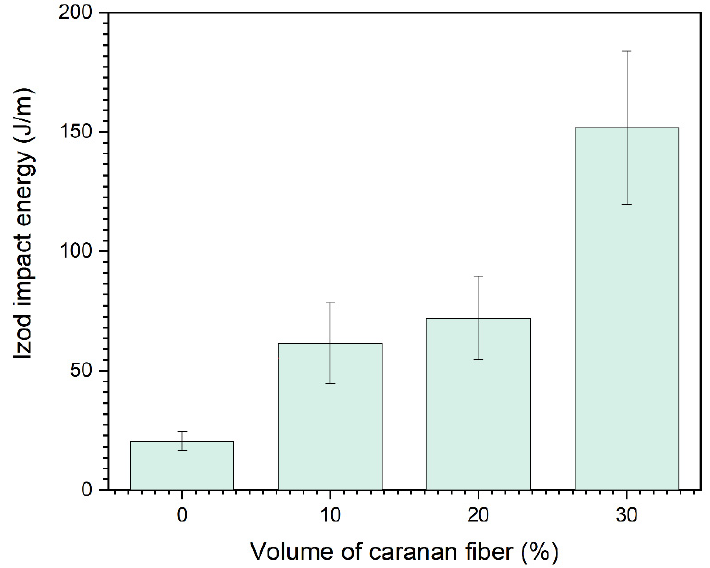
Figure 4. Izod impact energy as a function of the fiber fraction for the neat epoxy resin and caranan fiber-reinforced composites an increase of 637%.